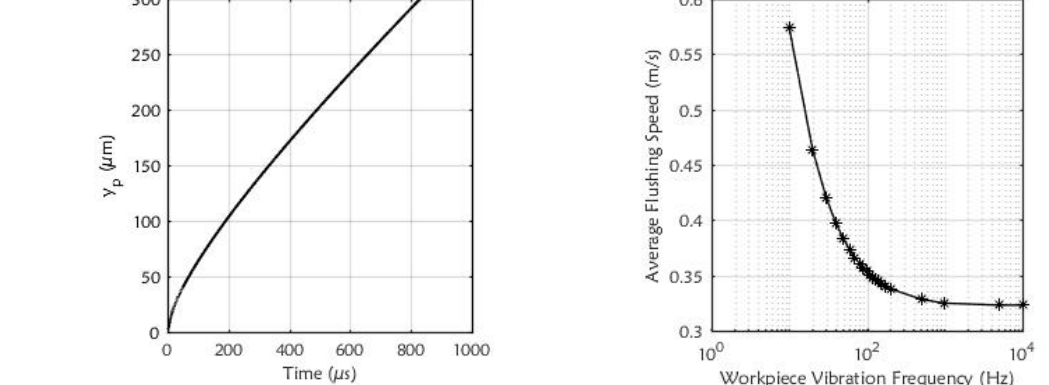
Figure 4: Particle movement in y-direction (f = 20 Hz; A v = 10 µm; S = 4 m/s)